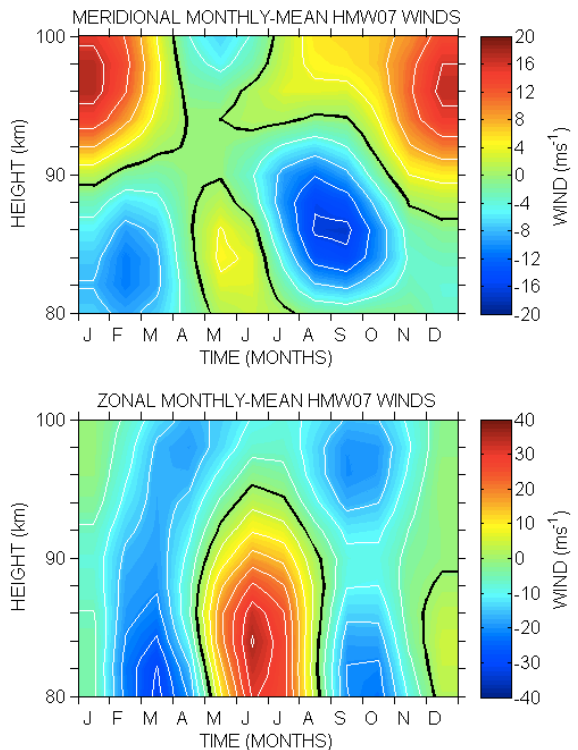
Fig. 5. Monthly-mean meridional and zonal winds over Ascension Island (7.94 ◦ S and 14.37 ◦ W), from the HWM-07 model. The zero Monthly-mean meridional and zonal winds over Ascension Island (7.94 ◦ S and Fig. 5. wind line is indicated in black, and the white lines indicate 5ms − 1 14.37 ◦ W), from the HWM-07 model. The zero wind line is indicated in black and the white lines indicate 5 m s − 1 steps.